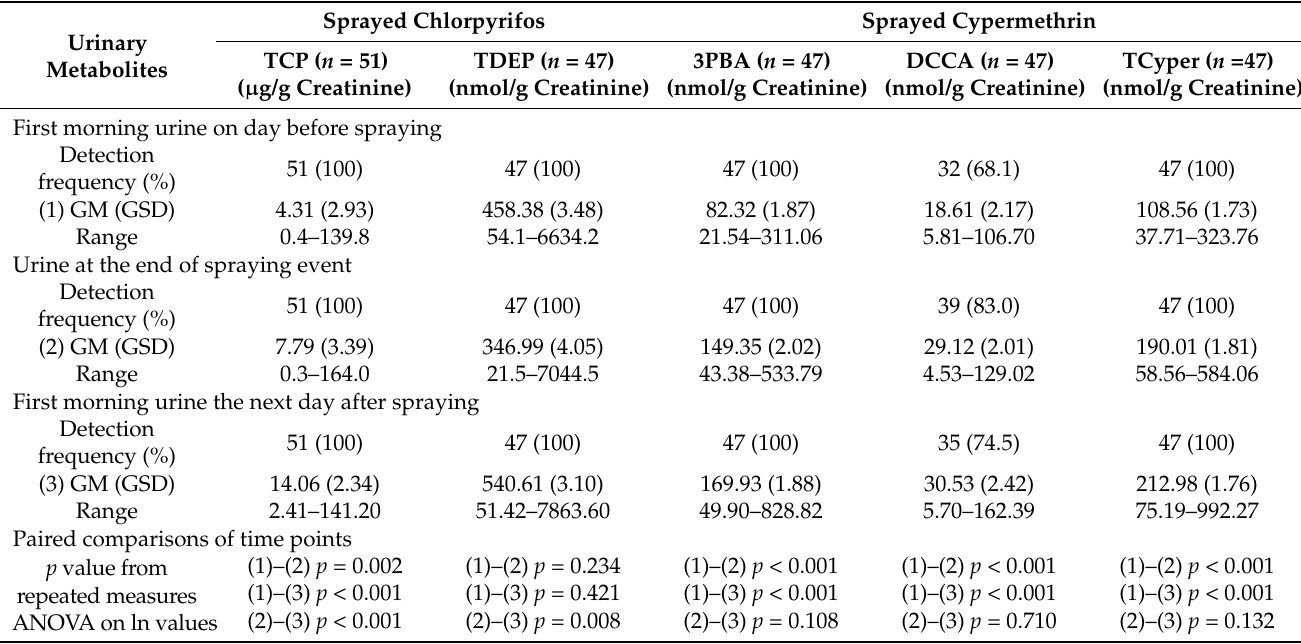
Table 3. Urinary metabolite concentrations at three time points for pesticide sprayers: morning void urine the day before spraying, end of spraying activity, morning void urine the day after